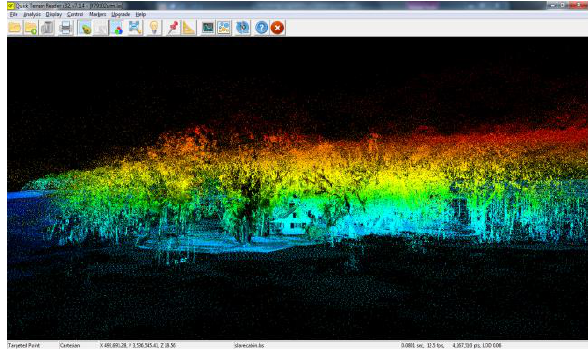
Figure 8. Integrated aerial LiDAR and terrestrial laser scan data for the slave cabin area at